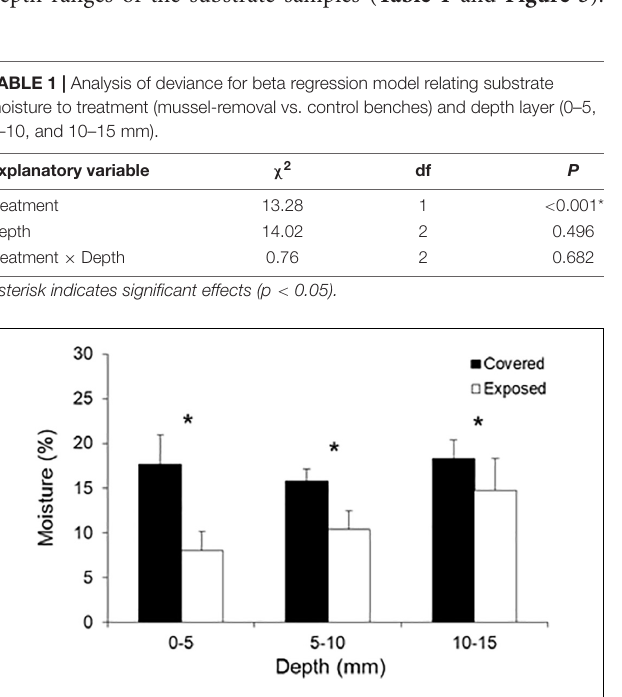
FIGURE 2 | Air temperatures at the surface of mussel-covered and mussel-removal (exposed) benches during a 3-h air-exposure period at noon on an exceptionally hot late-spring day (November 21, 2018). Each curve plots the data registered every 15 s by temperature loggers installed in two mussel-covered and two exposed benches (one logger per bench). The loggers attached to the mussel-covered benches were placed underneath the mussel layer.